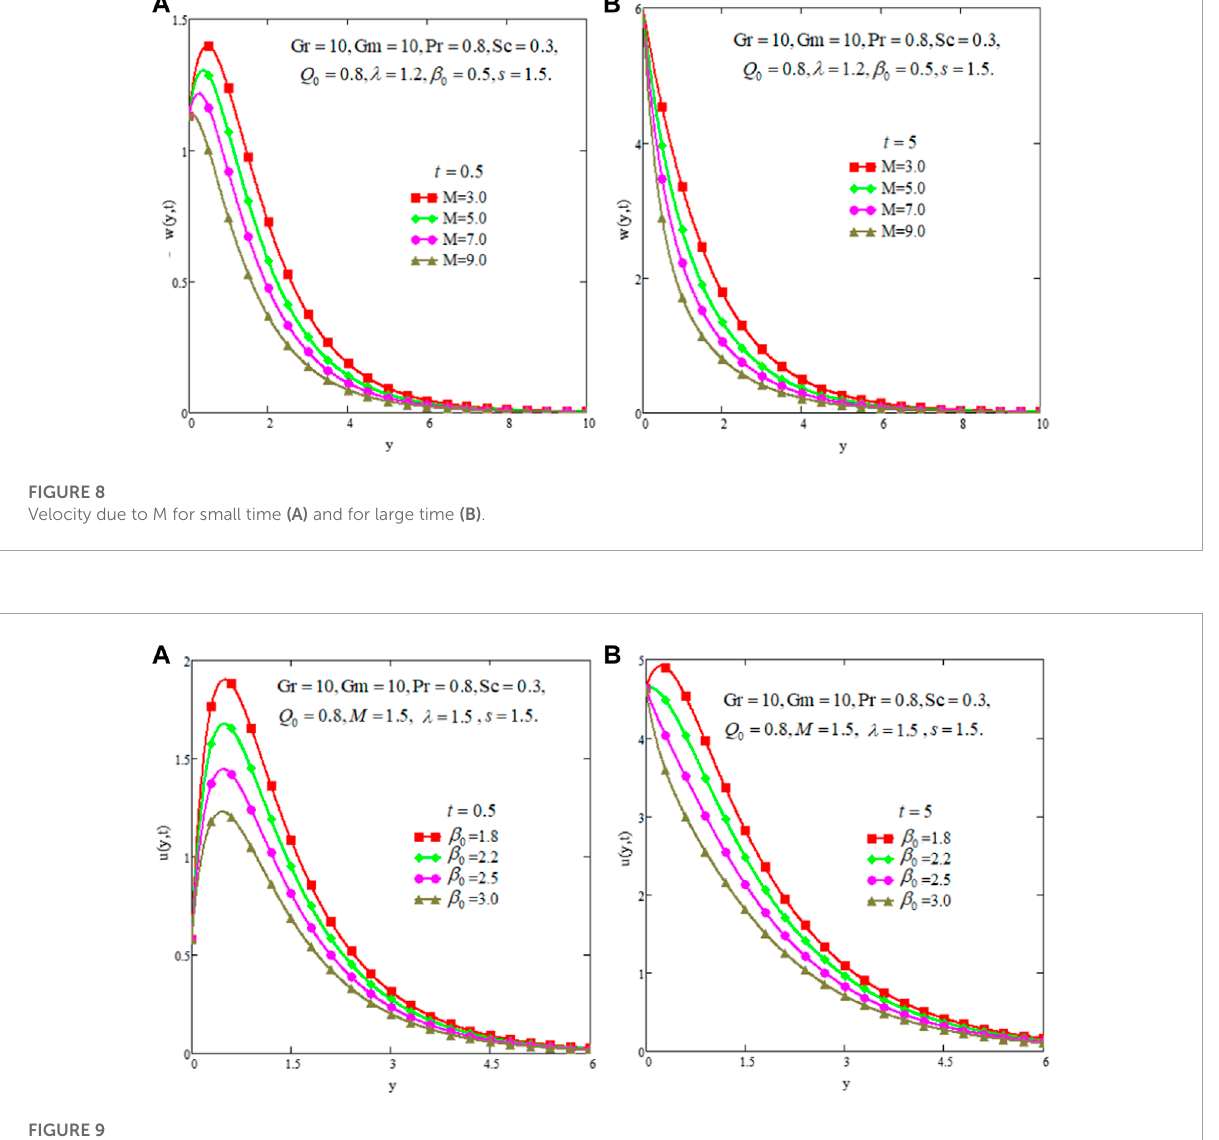
flow and consequently fluid slows down. Figures 5A,B present